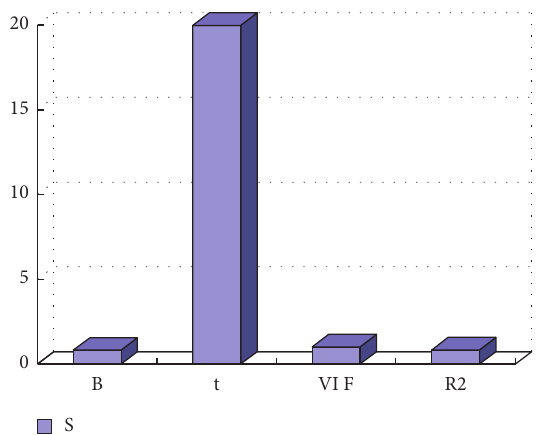
Figure 5: The regression model of Haitian background for TM.